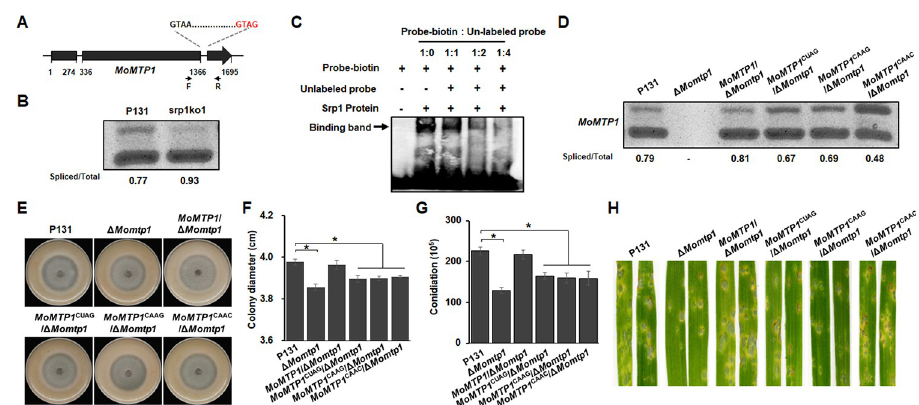
Fig 8. MoSrp1 suppresses the intron splicing efficiency of a novel virulence gene MoMTP1 . (A) Position of the 5’- GUAG-3’ motif in the MoMTP1 pre-mRNA. (B) RT-PCR analysis showing splicing efficiency of the second intron of MoMTP1 transcript in the Δ Mosrp1 mutant srp1ko1 as compared with the wild-type P131. The ratio between the spliced and the total introns was shown at the bottom of each line. (C) RNA-EMSA assay showing binding of MoSrp1 to the 5’-GUAG-3’ consensus in the MoMTP1 intron. (D) RT-PCR analysis on splicing efficiency of the second intron of the MoMTP1 transcript in strains P131, Δ Momtp1 , and MoMTP1 / Δ Momtp1 , the MoMTP1 CUAG transcript in strain MoMTP1 CUAG / Δ Momtp1 , the MoMTP1 CAAG transcript in strain MoMTP1 CAAG / Δ Momtp1 , and the MoMTP1 CAAC transcript in strain MoMTP1 CAAC / Δ Momtp1 . The ratio between the spliced and the total introns was shown at the bottom of each line. (E) The colony formed by strains P131, Δ Momtp1 , MoMTP1 / Δ Momtp1 , MoMTP1 CUAG / Δ Momtp1 , MoMTP1 CAAG / Δ Momtp1 and MoMTP1 CAAC / Δ Momtp1 strains on OTA plates at 5 dpi. (F) Statistics on colony diameters of the strains described in (E). (G) Conidia per petri dish produced by the strains described in (E) on OTA plates. The means and standard deviations in (F and G) were calculated based on three independent experiments each with three plates measured. Asterisk marks significant differences between P131 and mutant strains using t -test (p < 0.05). (H) Representative disease lesions on leaves of susceptible barley sprayed with conidia of the strains described in